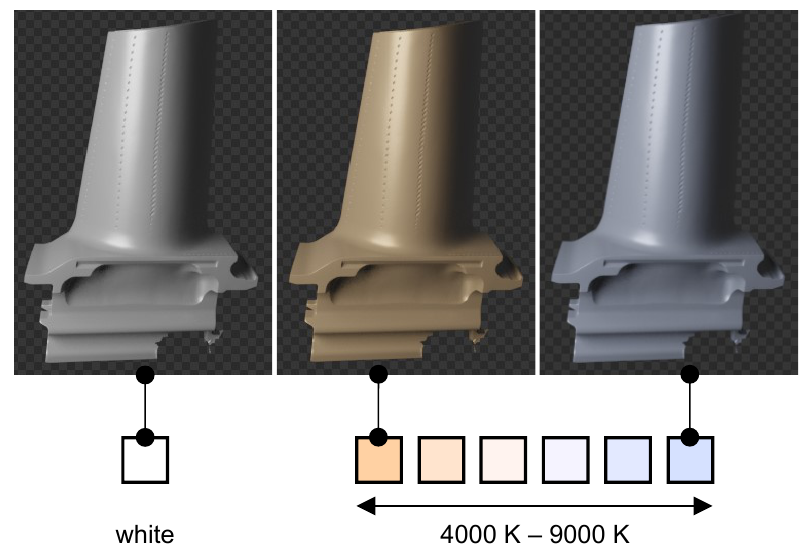
Figure 4. Each point light color is randomly sampled from six discrete values with color temperatures ranging from warm 4000 K to cool 9000 K in addition to white light. Ref. [49] was used for color conversions.